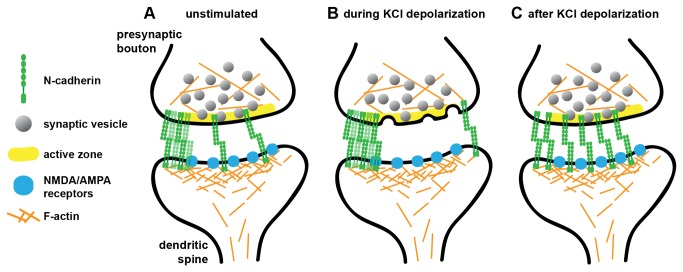
N-cadherin relocalizes to the center of the synapse after transient synaptic stimulation.(A) In unstimulated neurons, N-cadherin is present at synapses in a variety of distributions. It is primarily found as puncta near the edges of the active zone, but can also be present as a more uniform distribution along the synaptic cleft. (B) During KCl depolarization, there is less N-cadherin in the central region along the active zone, and more N-cadherin at periphery of the active zone. (C) After transient synaptic stimulation with KCl, N-cadherin relocalizes to form a broader central distribution along the active zone. This change in N-cadherin localization may have consequences for the increase in synaptic strength and stability following synaptic activity.